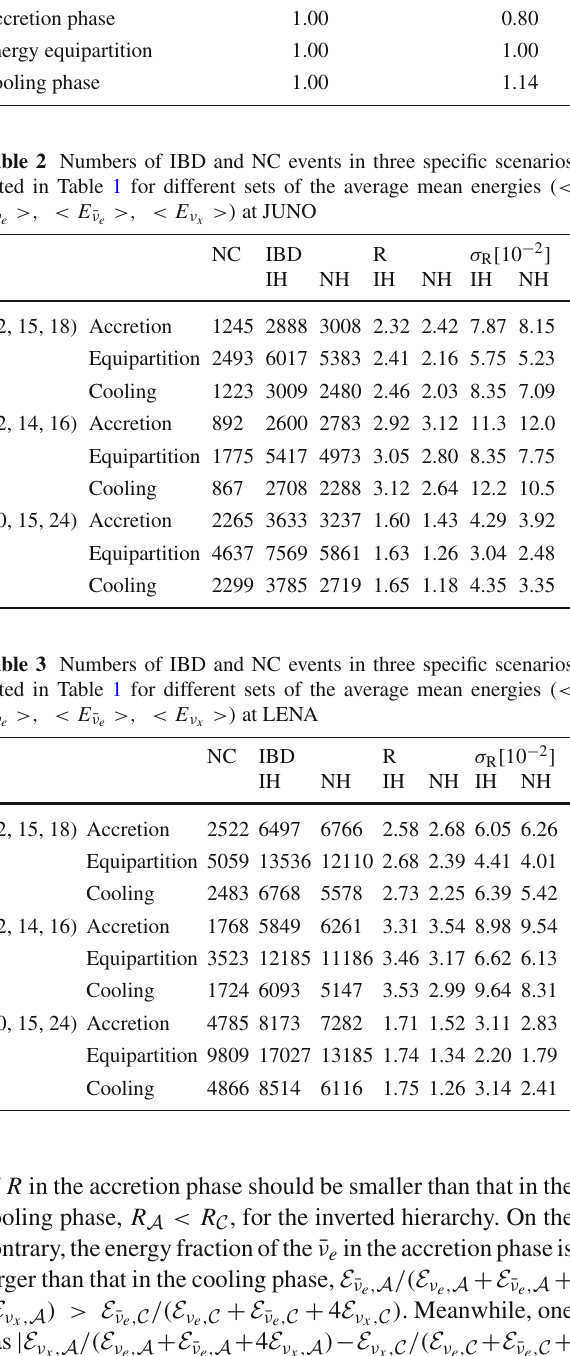
Table4 Detectorpropertiesforthefuturescintillationdetectorsconsid- eredinthiswork.Massesofscintillationmaterials,correspondingBirks constants ( k B ), numbers of free protons ( N p ), thresholds of quenched energy ( T (cid:7) ), and thresholds of proton recoil energy ( T min min